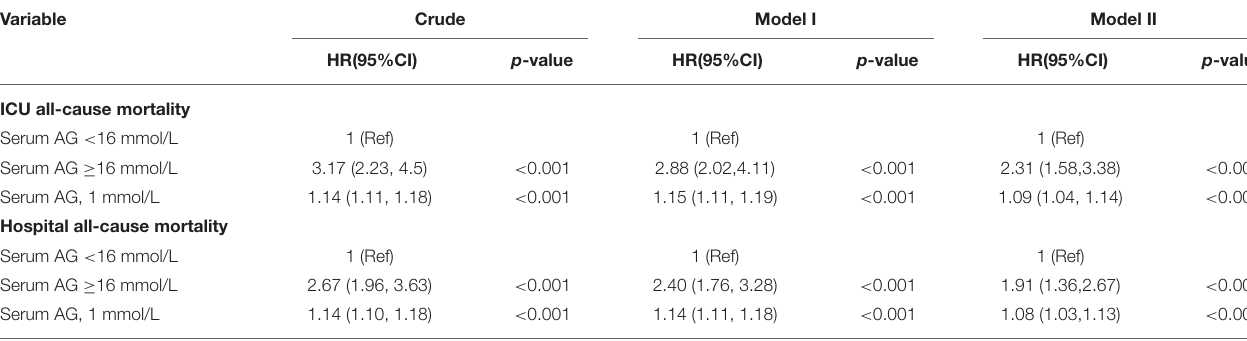
TABLE 3 | Multivariable cox regression models evaluating the association between serum Anion Gap and ICU and hospital all-cause mortality. Variable Crude Model I Model II HR(95%CI) p -value HR(95%CI)